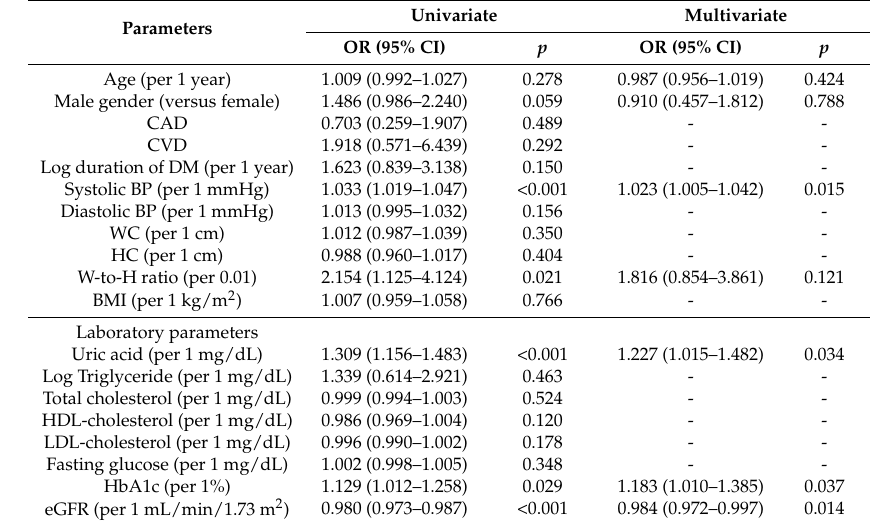
Table 2. Risk factors for urinary albumin-to-creatinine ratio (UACR) ě 30 mg/gm using binary logistic regression